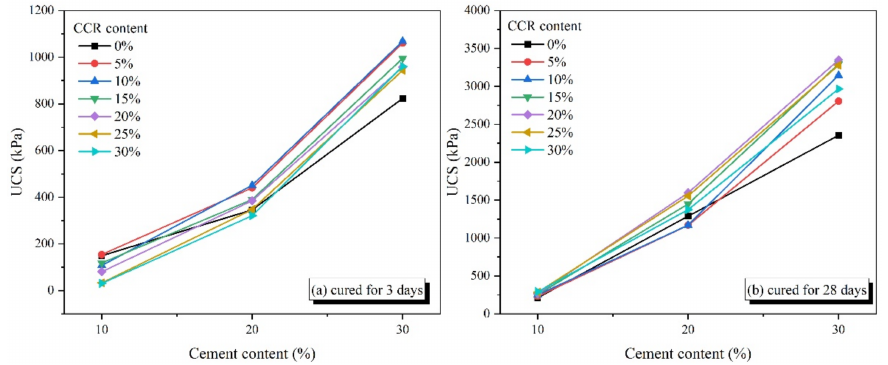
Figure 6. Effect of cement content on the UCS of CPDS cured for ( a ) 3 days and ( b ) 28 days under different CCR